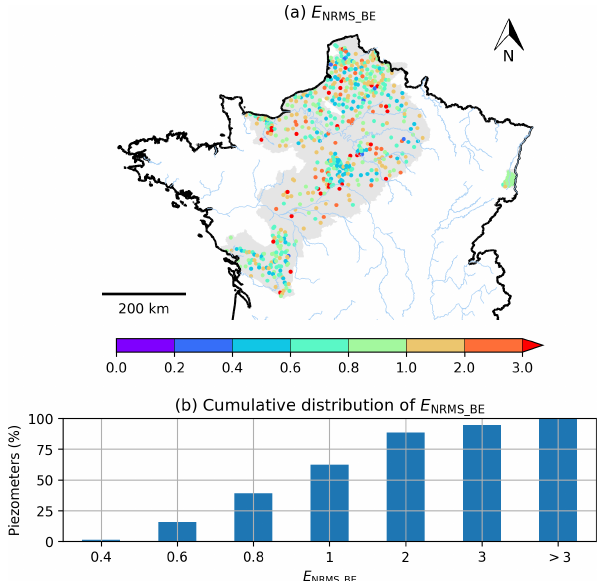
Figure 7. (a) Spatial distribution of E NRMS_BE calculated between the simulated and observed piezometric heads for the 639 selected piezometers. The grey background colour corresponds to the simu- lated aquifer domain. (b) Cumulative distribution of E NRMS_BE for all